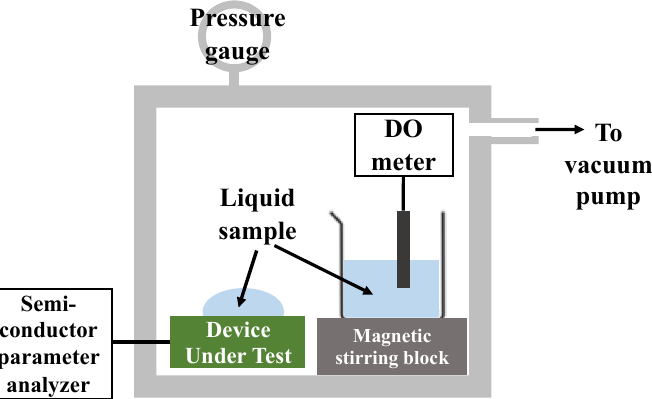
Figure 5. Schematic illustration of the experimental setup for DO measurement.